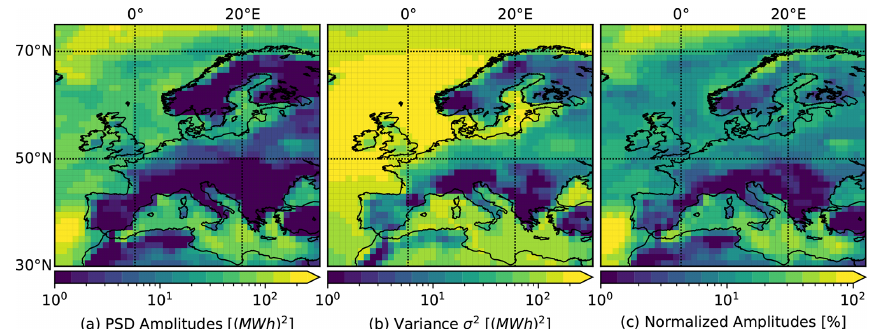
Figure 4. Analysis of multi-decadal peaks in the PSD for each grid point in Europe. (a) The maximum amplitude for multi-decadal timescales ν < 0 . 1yr − 1 in comparison to (b) the 3-hourly variance σ 2 . (c) The ratio of maximal amplitude and variance give the normalized amplitude. The shown signals are significant for a 90% confidence level at